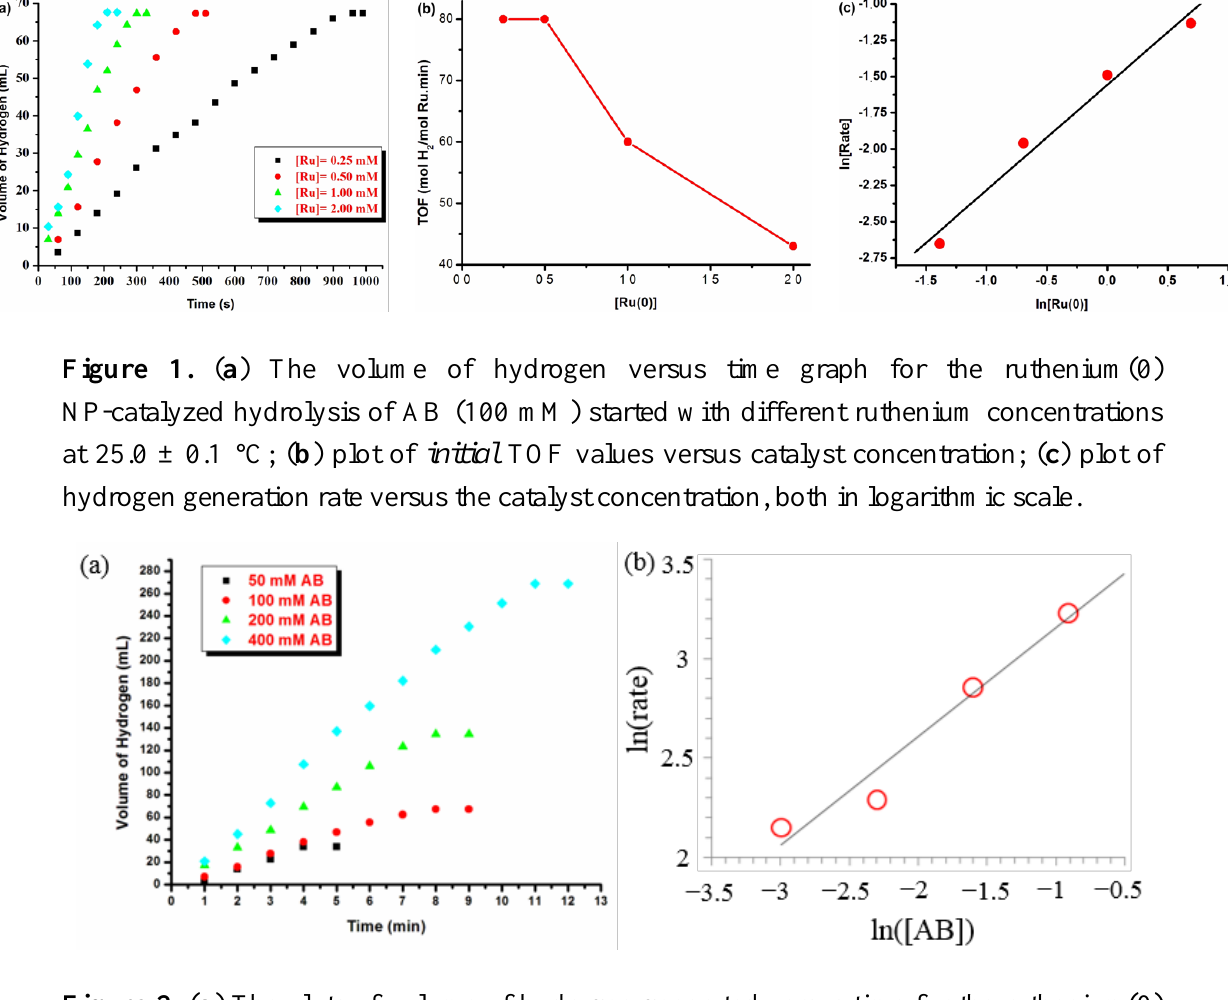
Figure 2. ( a ) The plots of volume of hydrogen generated versus time for the ruthenium(0) NP (0.50 mM) catalyzed hydrolysis of AB starting with different AB concentrations in the range of 50–400 mM at 25.0 ± 0.1  C; ( b ) the logarithmic plot of hydrogen generation rate versus ammonia-borane concentration, both in logarithmic scale, for the same